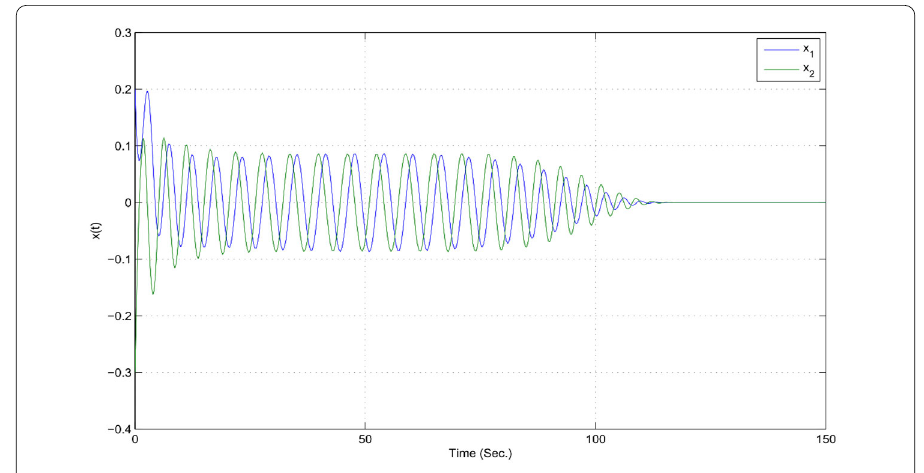
Figure 2 The state responses for Example 1